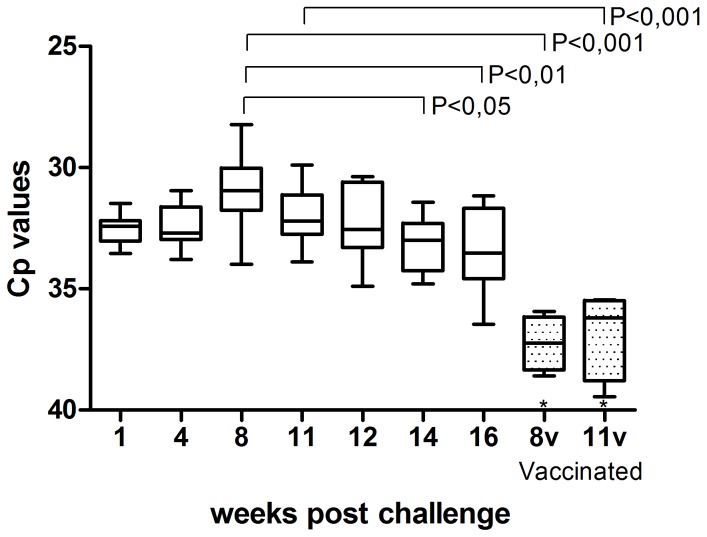
Sequential development of ASCV viral load in kidney specimens following experimental challenge of Atlantic salmon.The viral load of ASCV was measured by real-time PCR. Results are presented as a box plot (whiskers and minimum to maximum). Fish were challenged by intramuscular injection as non-vaccinated (blank boxes, representing 9–10 individuals per sampling) or vaccinated (patterned boxes, representing four individuals each, *three samples were negative and not included). Significant differences are indicated by brackets.